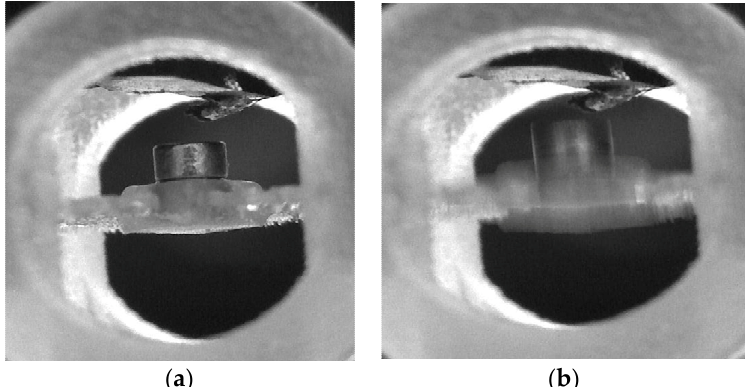
Figure 5. ( a ) Images captured by the video systems at steady state and ( b ) during the resonance vibrations with 1.32 mm amplitude.